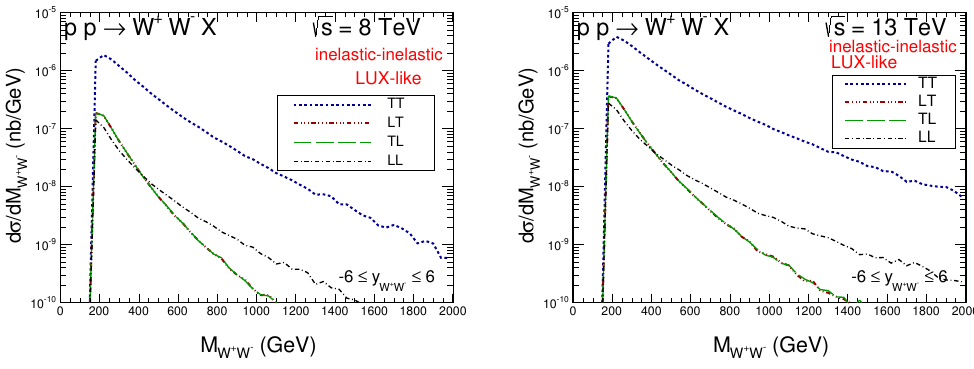
Figure 15 . Decomposition into polarization states of W bosons for the inelastic-inelastic component as a function of M WW . The calculation was performed for the LUX-like structure function. The left panel shows results for W = 8 TeV, while the right panel shows results for W = 13 TeV. into di(cid:11)erent polarization states of W bosons as a function of the W W invariant mass. We observe that the T T component dominates in the whole invariant mass